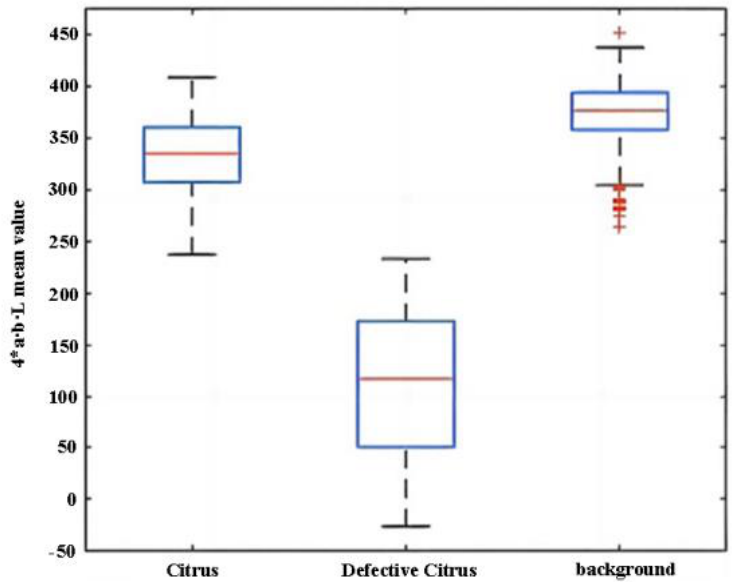
Figure 8. Boxplot of 4*a − b − L feature mean. The three red lines of the three blue boxes in the figure are the median of the feature of citrus, defective citrus and background respectively. The two lines above and below the blue box represent the maximum and minimum values of the feature.